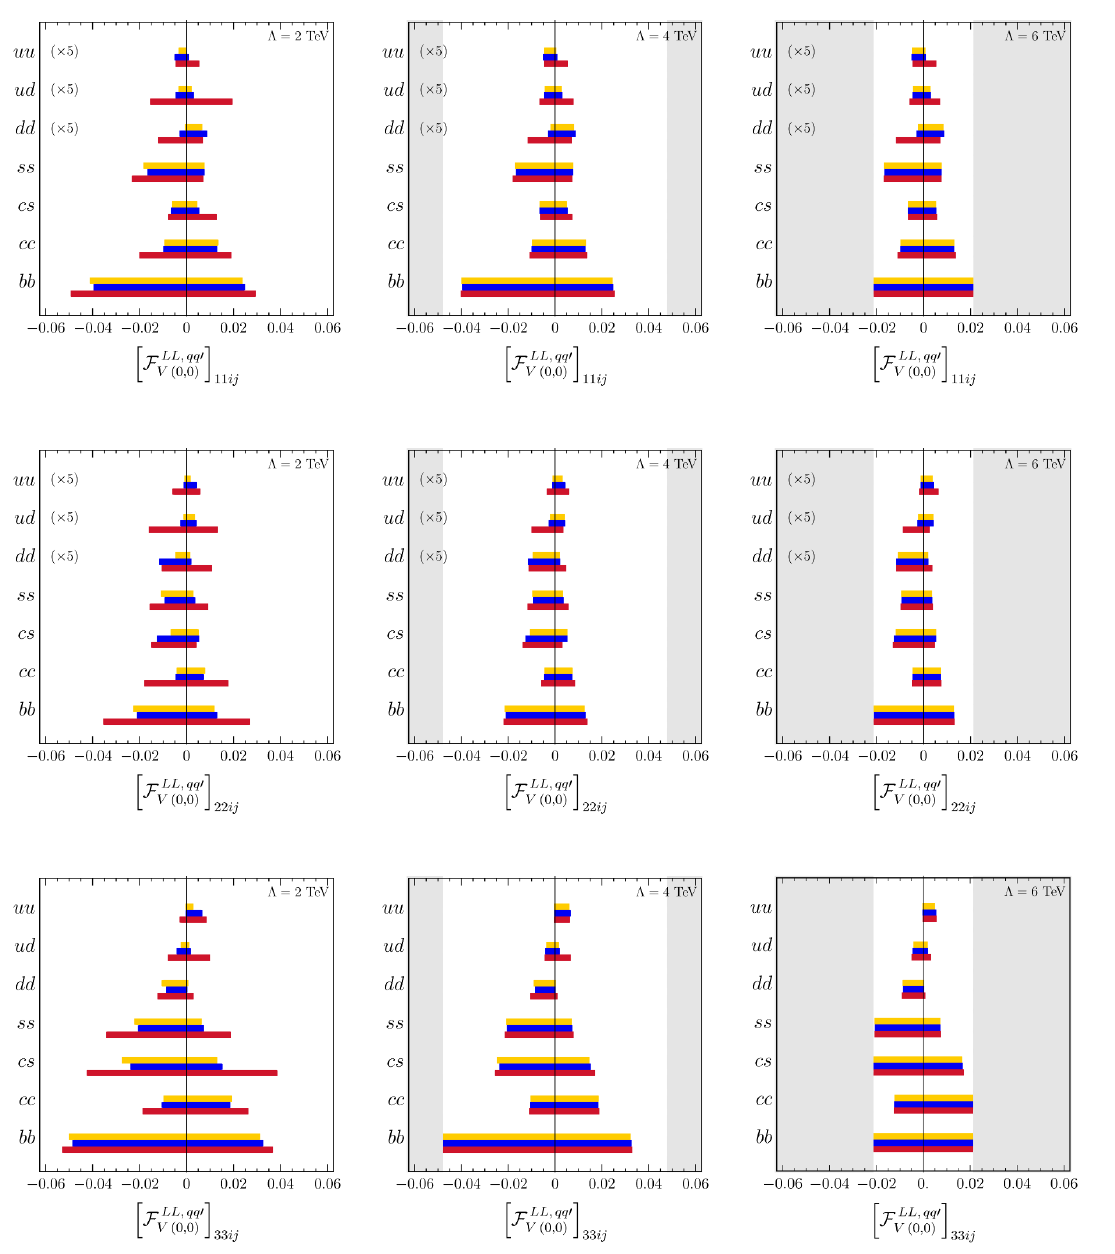
for first generation (top panel), Figure 9. 95% CL limits on the form-factor coefficients F LL V (0 , 0) second generation (middle panel) and third generation (bottom panel) leptons using LHC run-II searches in the dilepton and monolepton channels. Blue intervals are single-parameter limits, the red ones are limits marginalizing over momentum-dependent effects from d = 8 operators, and the yellow ones are the expected limits from d = 6 and d = 8 operators assuming a specific UV scenario. For the first two rows, the limits for uu, dd, ud have been rescaled by a factor of 5 for visibility. The gray bands, given by |F LL,qq 0 | ≥ 4 π v 2 / Λ 2 , correspond to the region where perturbative unitarity I (0 , 0) is expected to break down. See text for more